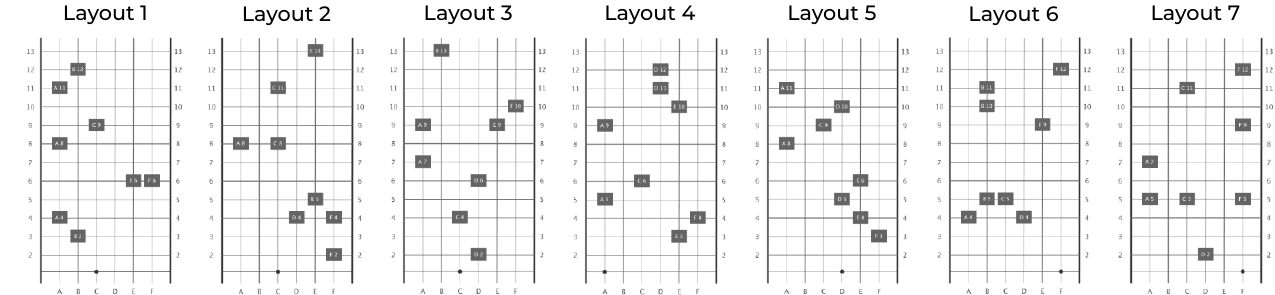
Figure 3. The seven obstacle course layouts used in the study (in non-mirrored variant).